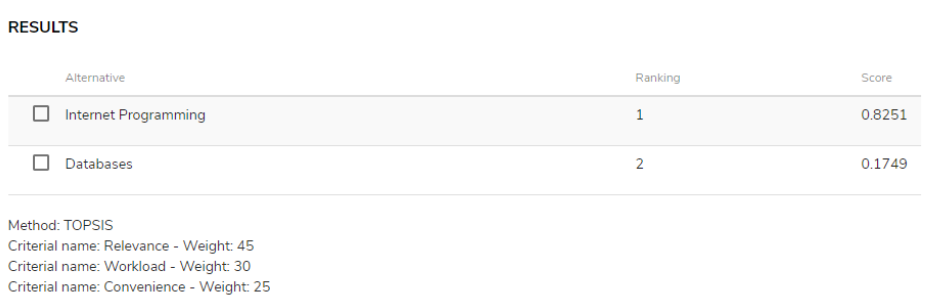
Figure 12. TOPSIS input.